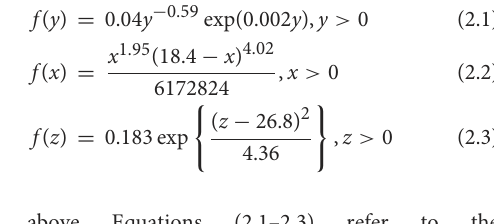
temperature with parameters ( α 0 and b 18.3) oC and Gaussian distribution for average yearly = maximum temperature with parameters ( µ oC were identified as the best marginal distributions, indicated by bold (Table